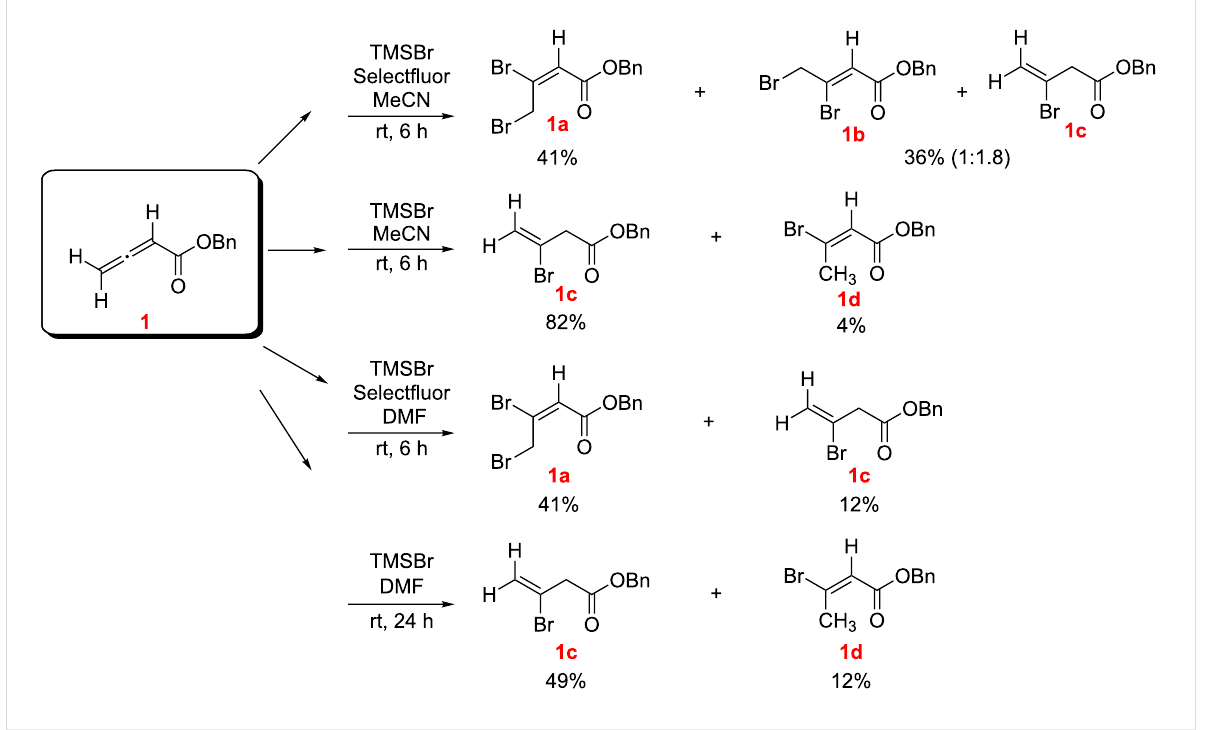
Scheme 1: Reaction of benzyl allenoate ( 1 ) with TMSBr with and without Selectfluor ( E/Z designations, as illustrated, were made by NMR; see Supporting Information File